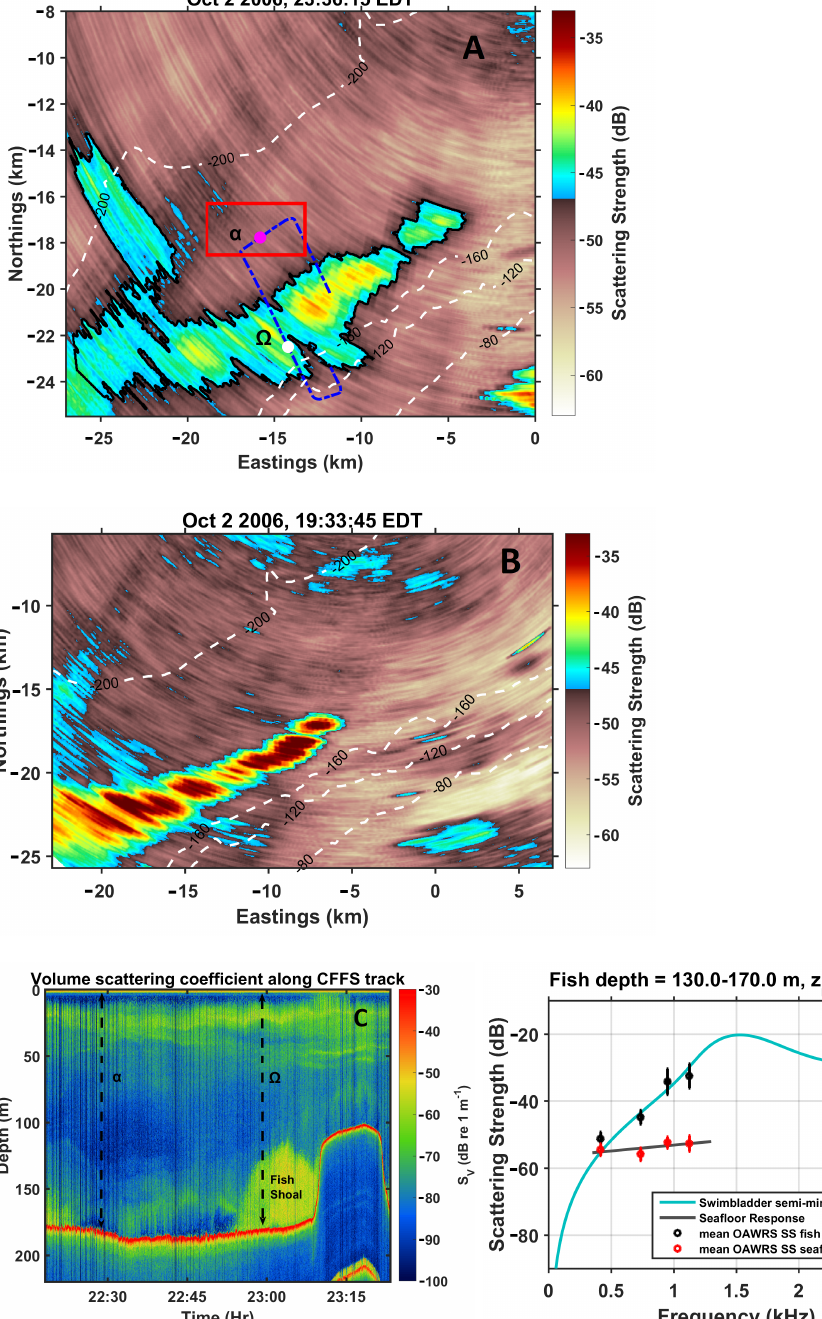
Figure 5. Same as Figure 3 except OAWRS scattering strength in ( A ) is measured on 2 October 23:36:15 EDT and ( B )—on 2 October 19:33:45 EDT, echosounder tracks in ( C ) are shown with blue line in ( A ) and scattering strength versus frequency for fish and seafloor in ( D ) are within black and red contours,